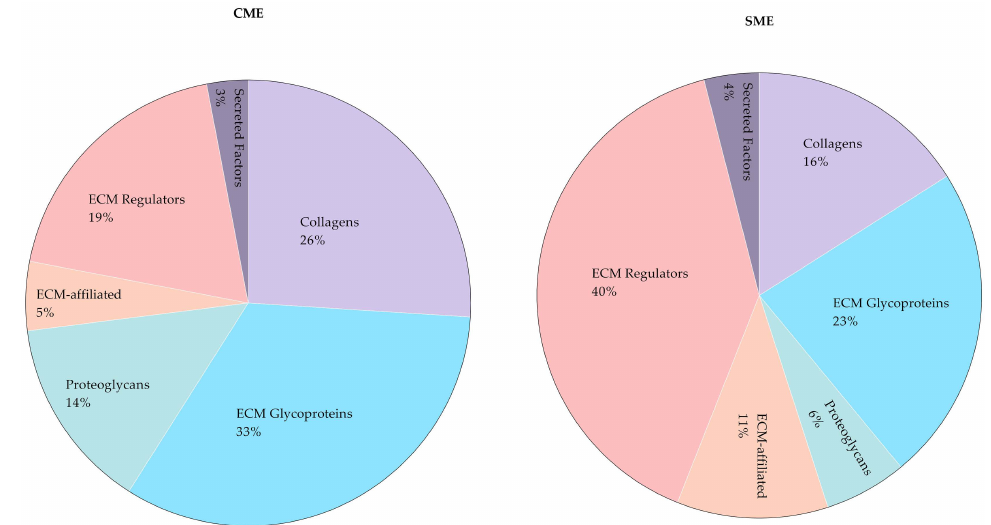
Figure 4. Relative abundance of matrisome proteins in healthy mouse kidneys according to MaxQuant LFQ protein intensities. The results are presented separately for the products of CME and SME